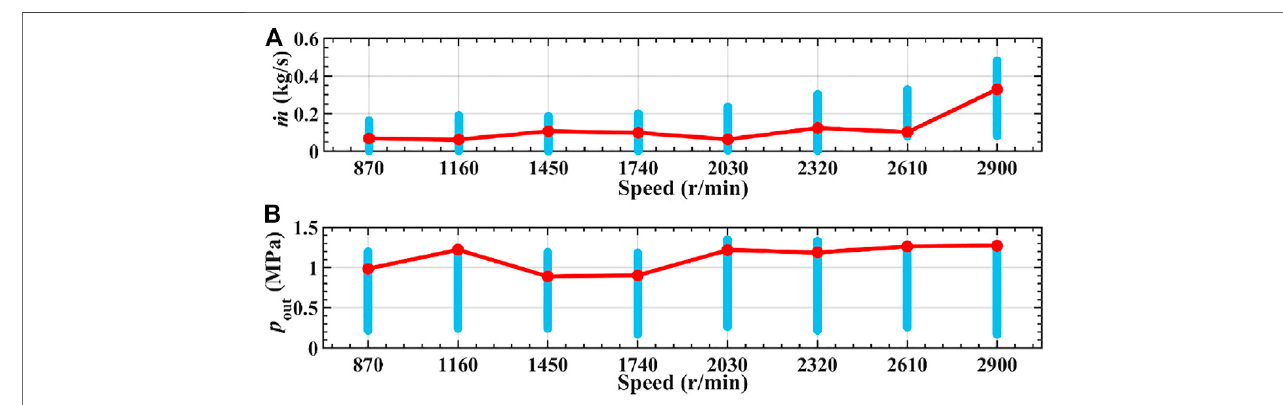
FIGURE 13 | Distribution of the optimal key operating